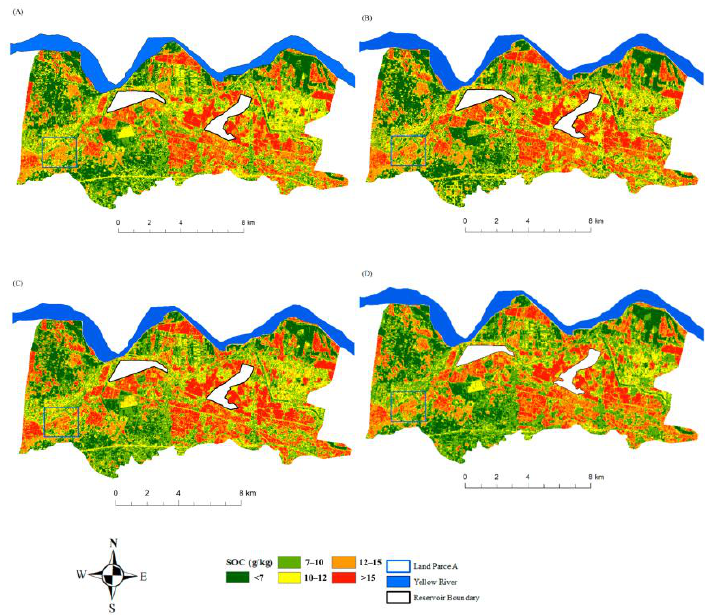
Figure 4. Spatial pattern of SOC in the study area based on ( A ) the LT model; ( B ) the LTb model; ( C ) the LTi model; ( D ) the LTg model.